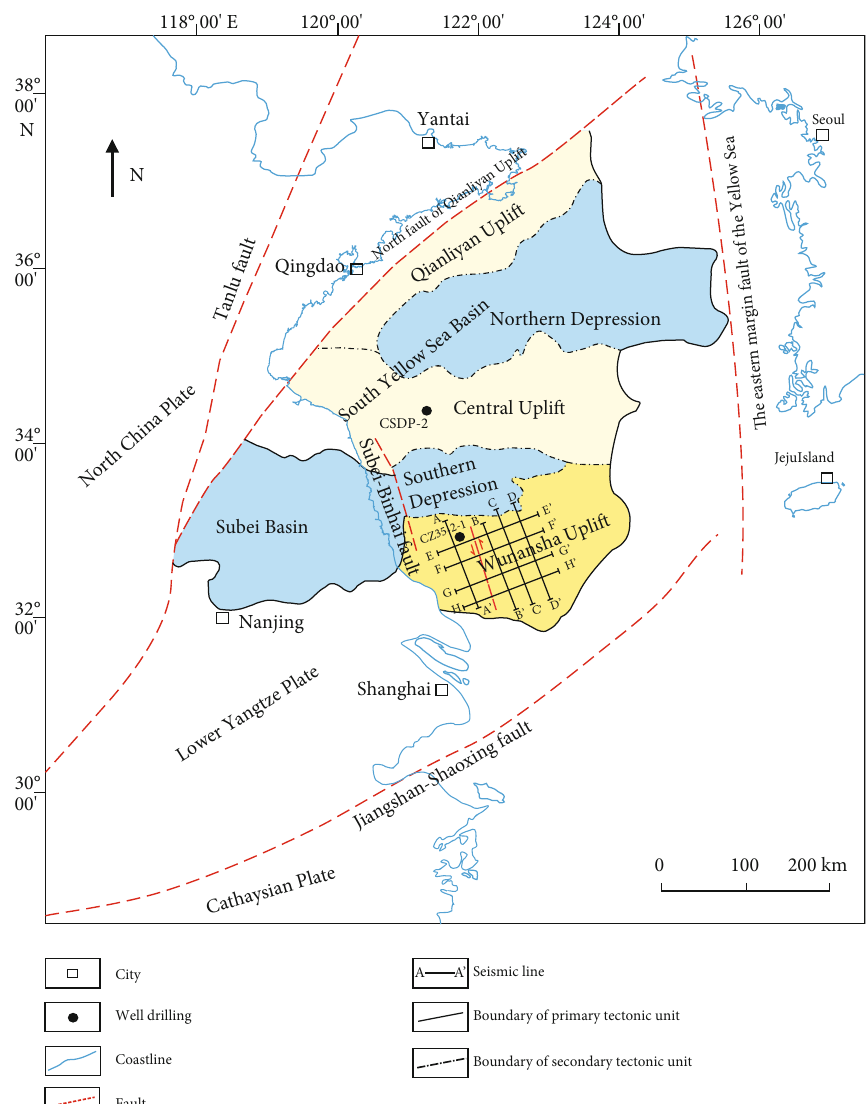
Figure 1: Structural division of the South Yellow Sea basin and its adjacent areas (after